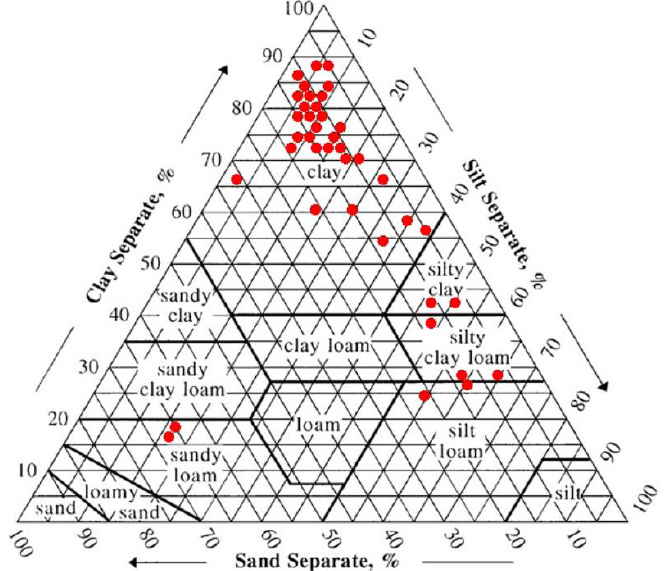
Figure 4. Bottom sediment texture triangle of Lake Tana based on USDA soil classification criteria.